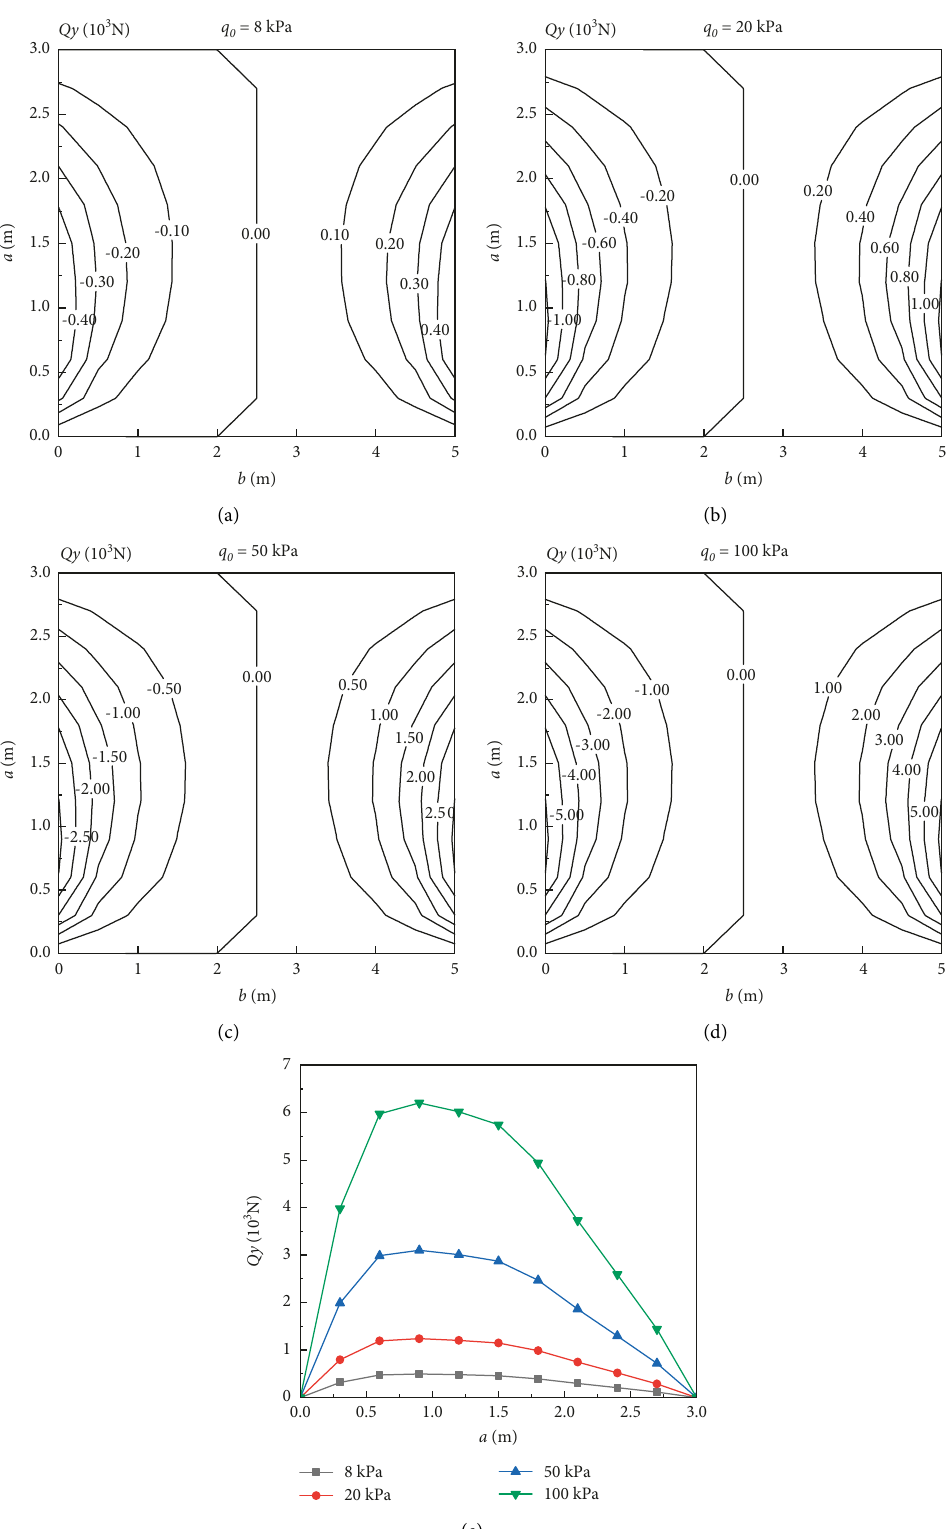
Figure 11: Effect of frost heaving force on shear force Q